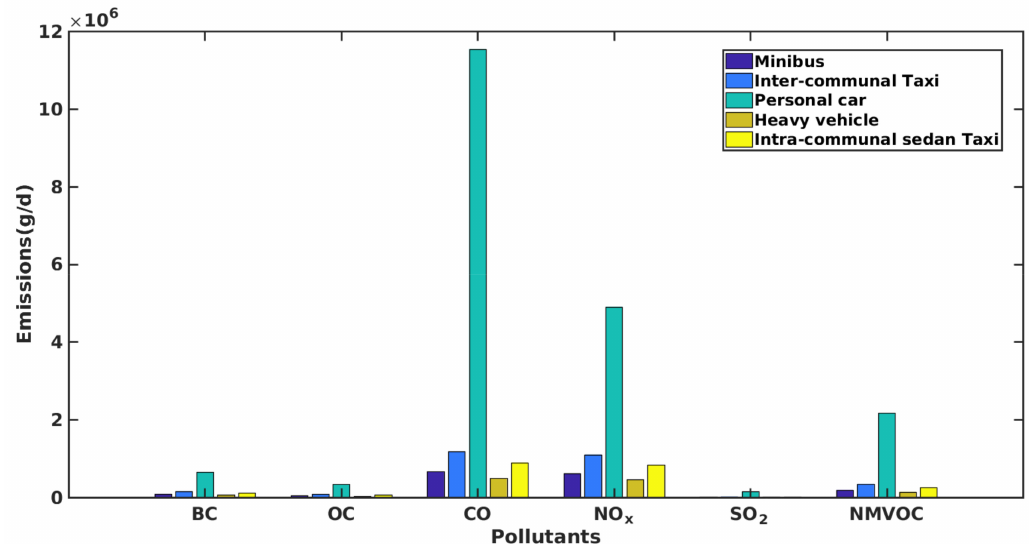
Figure 5. Traffic emission contribution by different vehicle types in